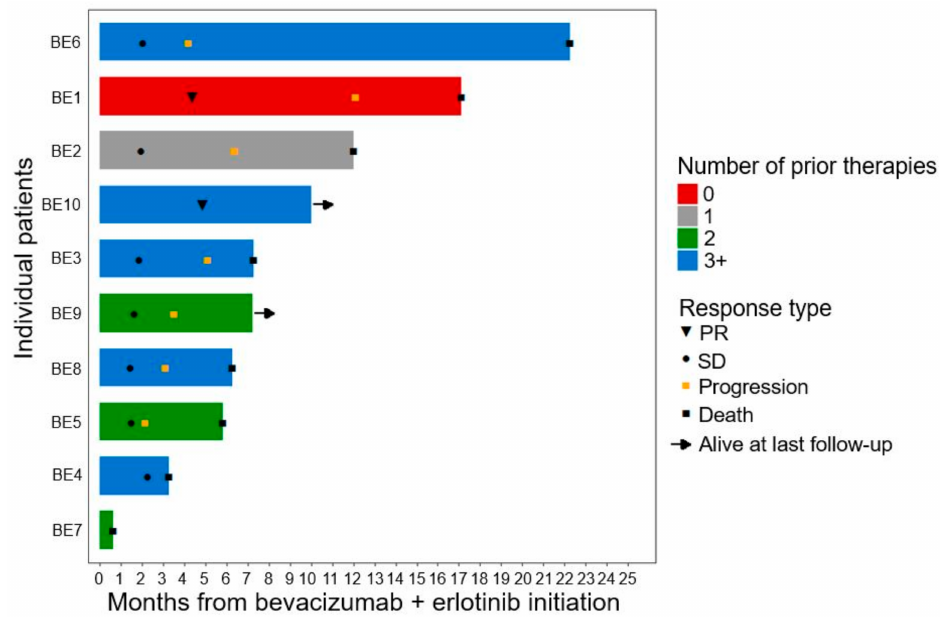
Figure 2. Duration of bevacizumab plus erlotinib. All 10 patients were included in this swimmer plot for duration of therapy, sorted by number of therapies before bevacizumab plus erlotinib. PR, partial response; SD, stable disease.